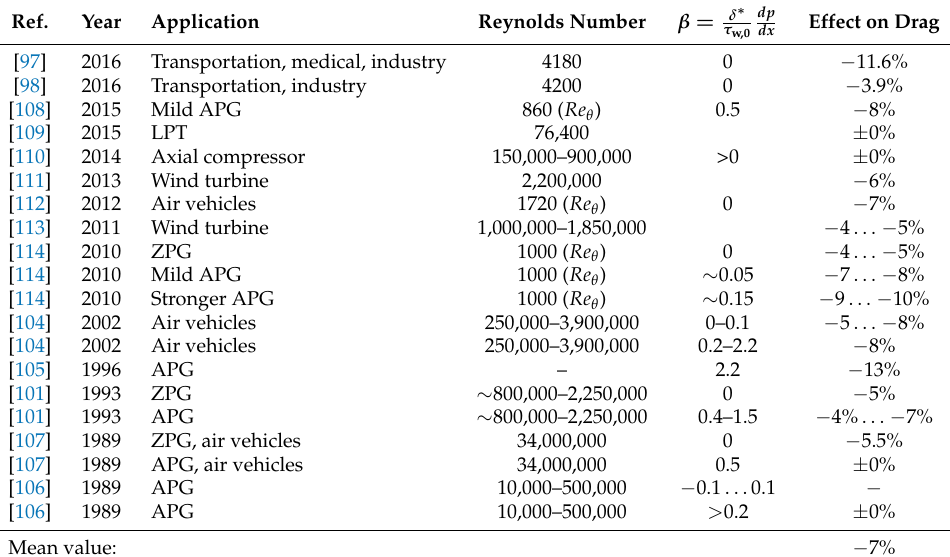
Table 7. Representative summary of the riblet investigations at different values of Clauser parameter β .